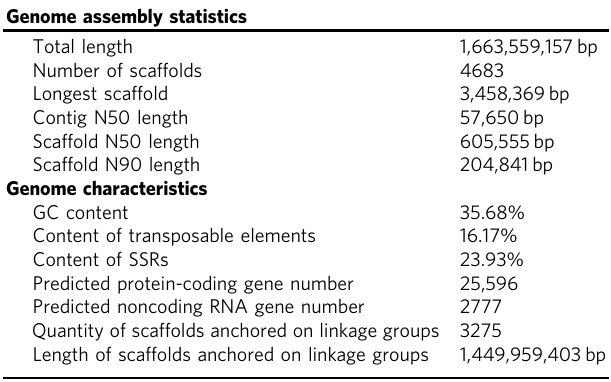
Table 1 Summary of L. vannamei genome